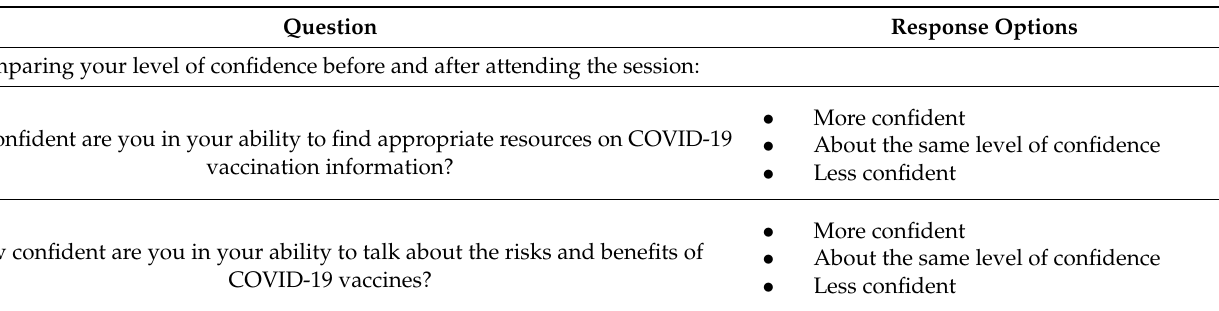
Table A1. Vaccine Champions Evaluation